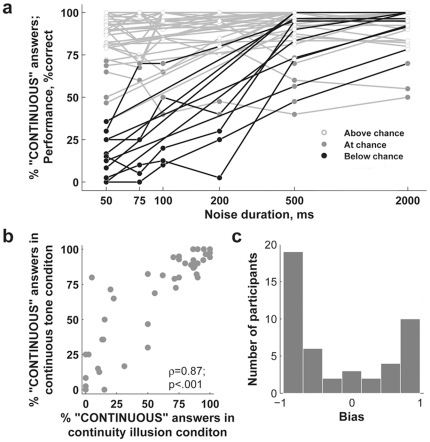
Illusory discontinuity.
a. Individual performance in the continuous-tone-with spectrally-remote noise condition (Figure 1a). Subjects that exhibited illusory auditory discontinuity in trials with 50-ms noise bursts are drawn with black lines plotted in the foreground; all other subjects are plotted in gray. The color of the points indicates individual performance relative to chance levels defined by the binomial distribution. “Above chance” performance indicates a proportion of continuous responses significantly greater than chance at the p<0.05 level, while “below chance” indicates significantly fewer continuous responses than expected by chance (n = 46 for noise durations of 50, 500, and 2000 ms, n = 18 for 75,100 and 200 ms; individual chance levels are slightly different because of different numbers of trials.) b. Relationship between continuity responses in the continuous tone with spectrally remote noise condition (y-axis) and discontinuous tone covered by noise condition (x-axis). Each dot is a single subject; data come from 50 ms noise durations, n = 46. c. Distribution of individual response biases. ‘−1’ signifies a bias towards ‘discontinuous’ responses, and ‘1’ a bias towards ‘continuous’ responses. The data come from the same trials with 50-ms noises (n = 46).